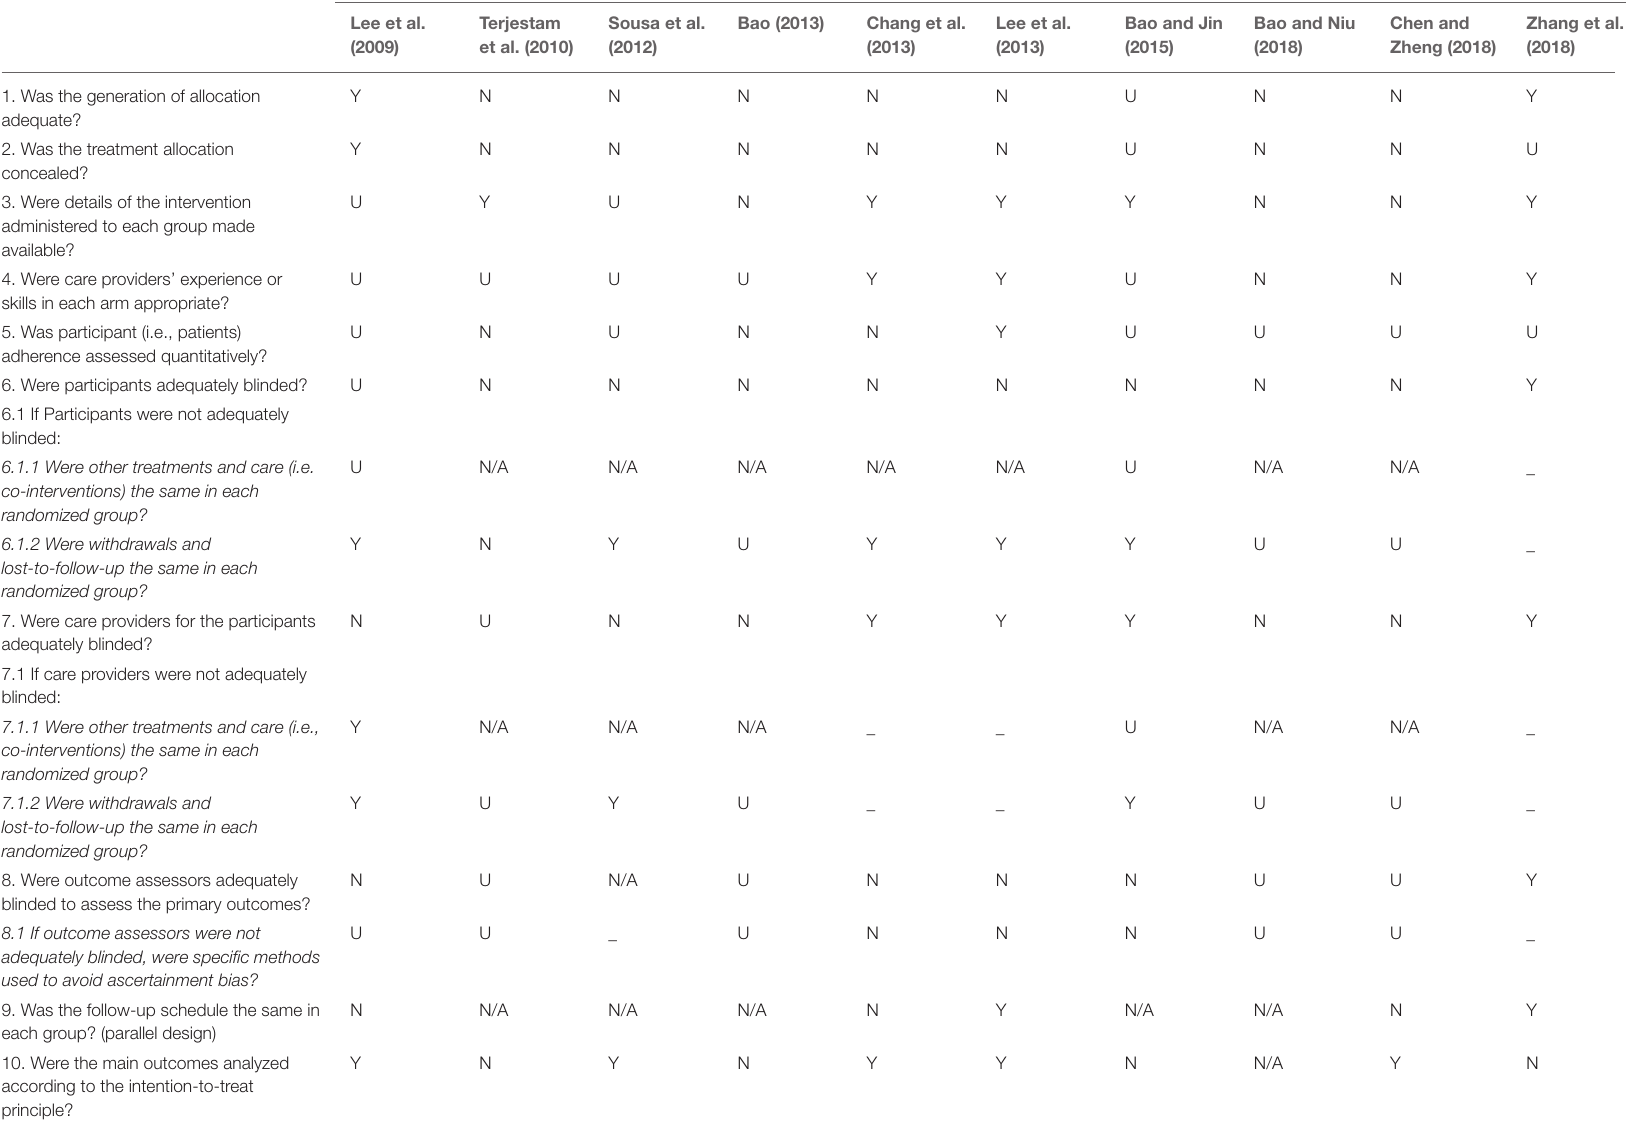
TABLE 3 | Critical appraisal of included studies ( n = 10).